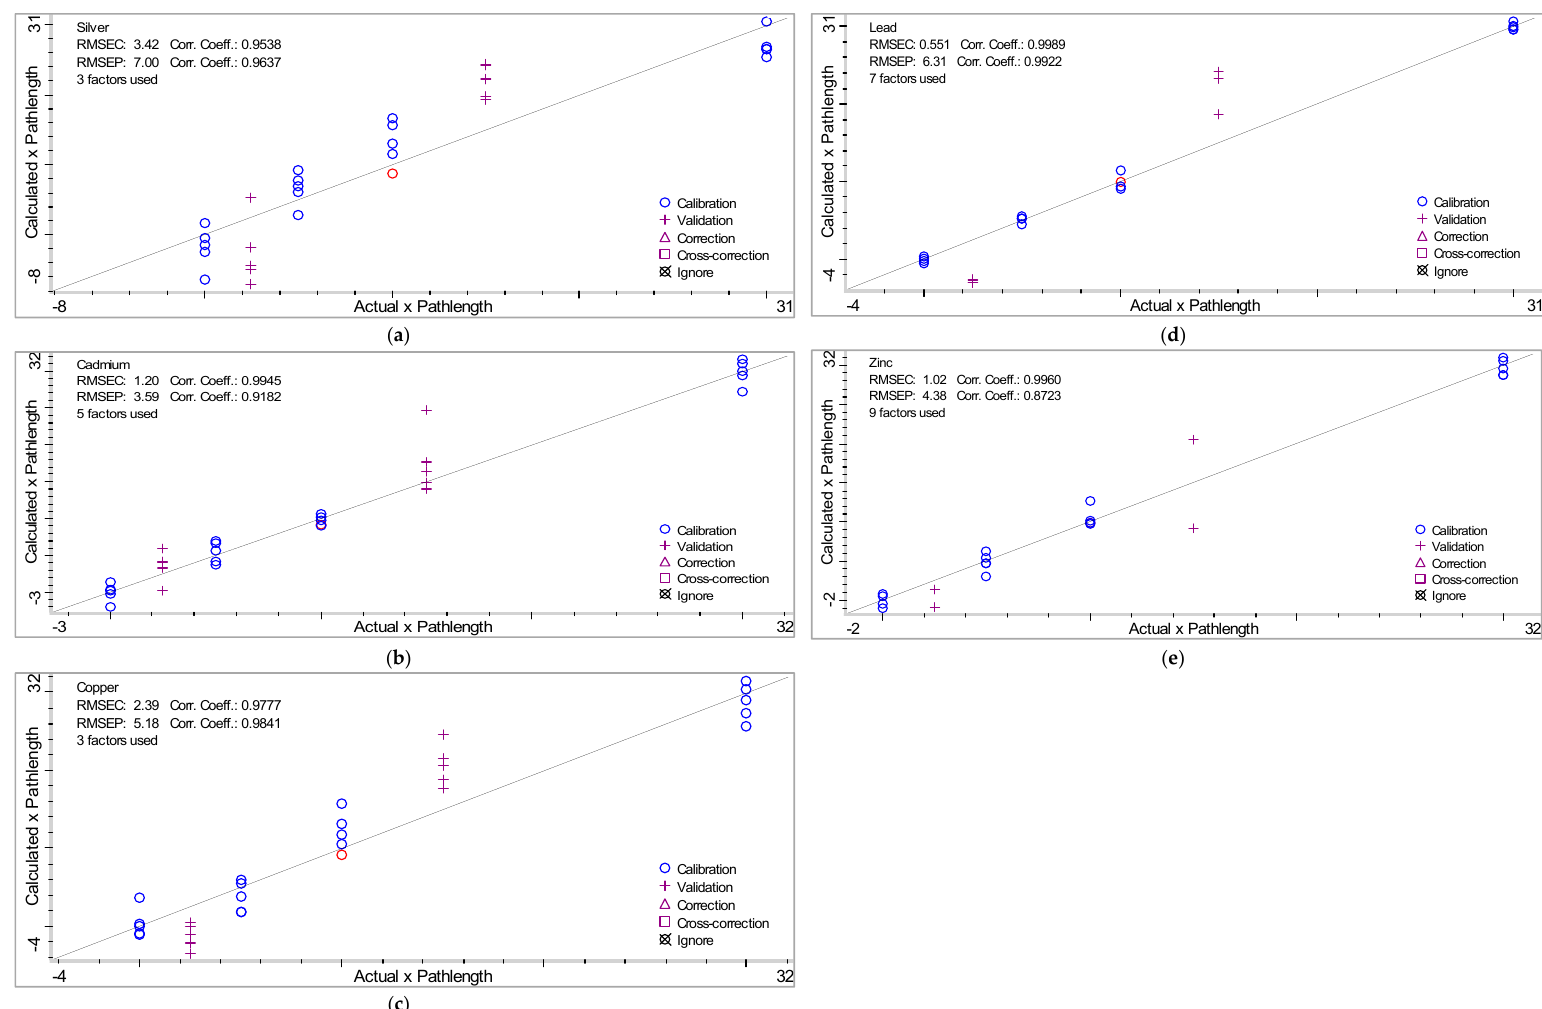
Figure 3. Showing the PLS calibration models for caption ( a ) Ag; ( b ) Cd; ( c ) Cu; ( d ) Pb; and ( e ) Zn.